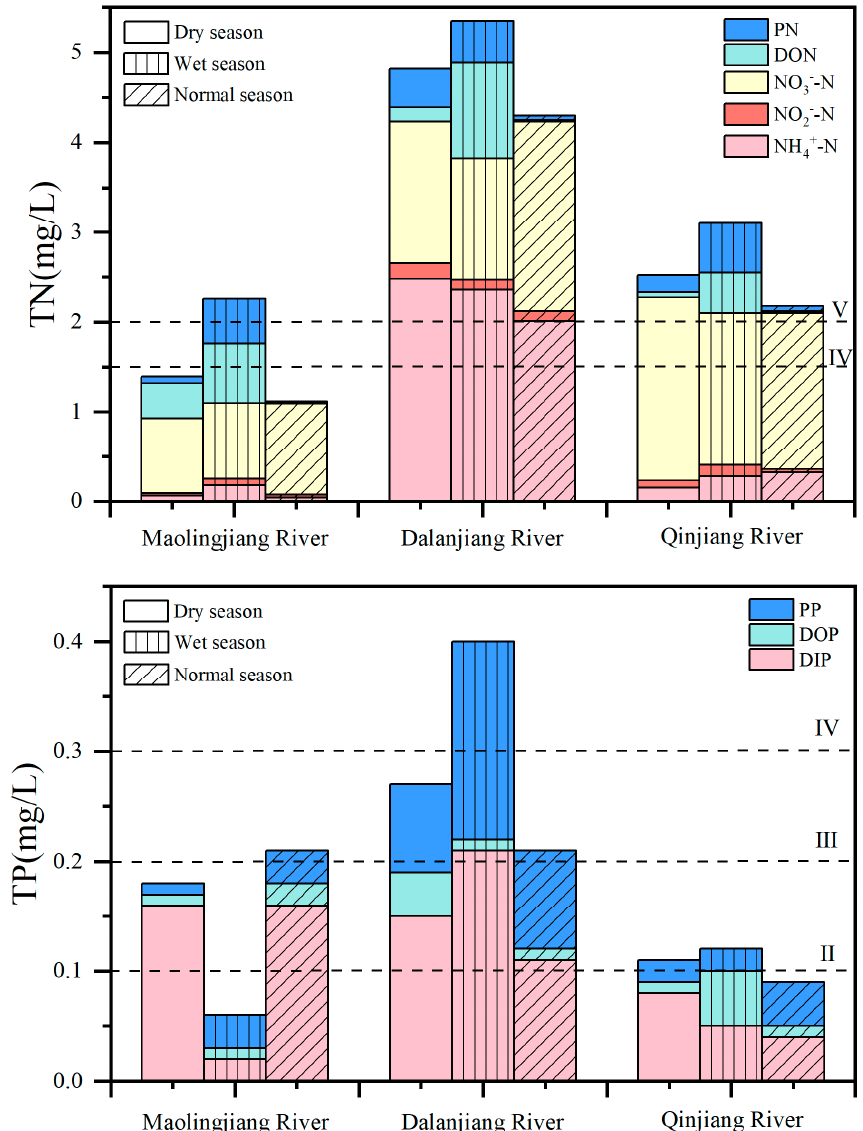
Figure 2. Seasonal nitrogen and phosphorus concentration and composition in the estuary of the Maowei Sea.